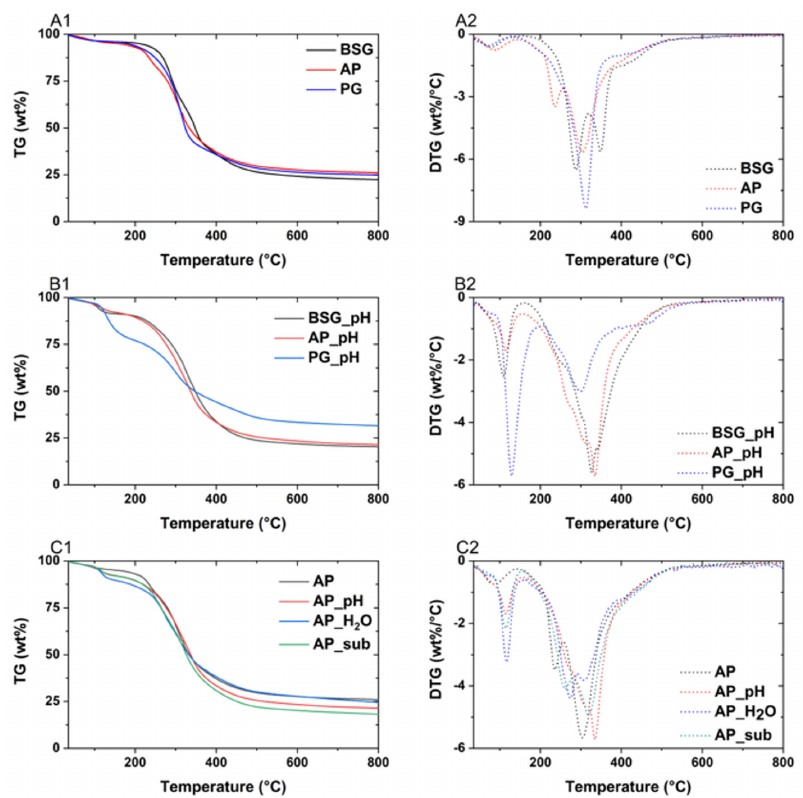
Figure 4. Comparison among TGA of original feedstock ( A ), proteins isolated from di ff erent feedstock by alkaline treatment ( B ), and Arthrospira platensis (AP) protein extracted by di ff erent treatments ( C